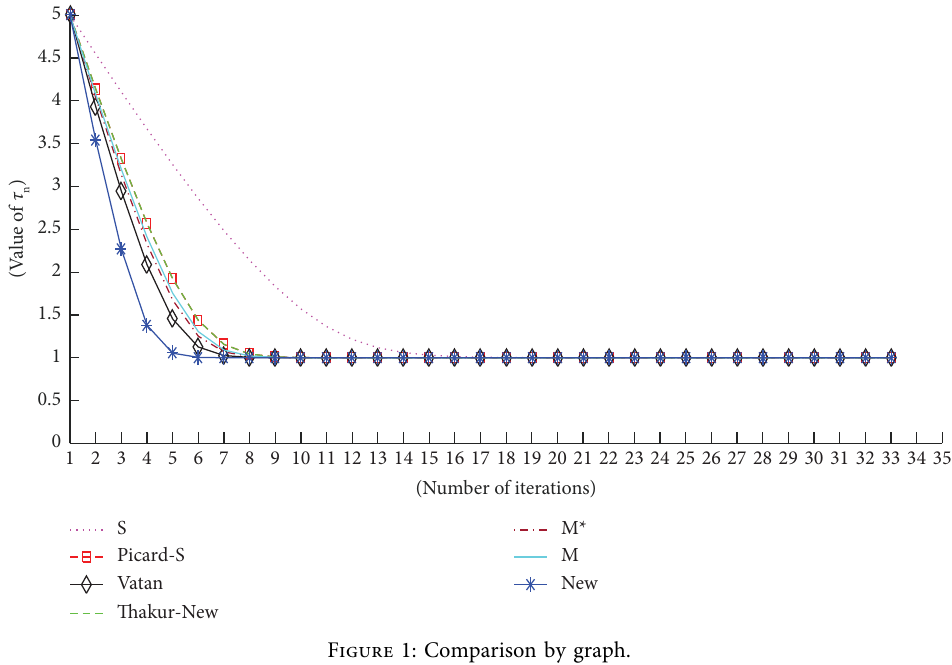
Figure 1: Comparison by graph.